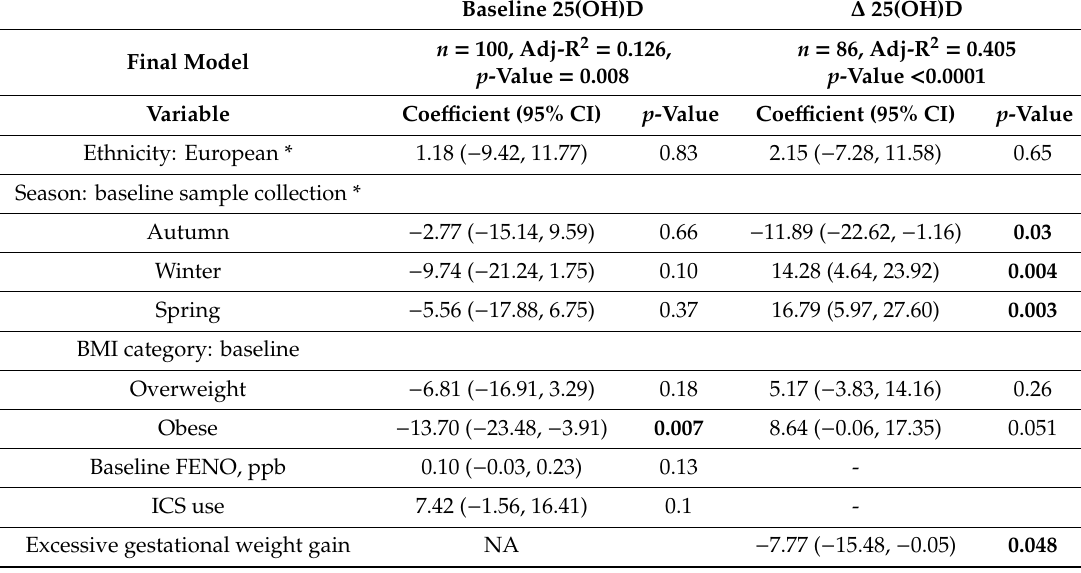
Table 2. Asthma- and lifestyle-related variables associated with 25(OH)D levels in pregnant women with